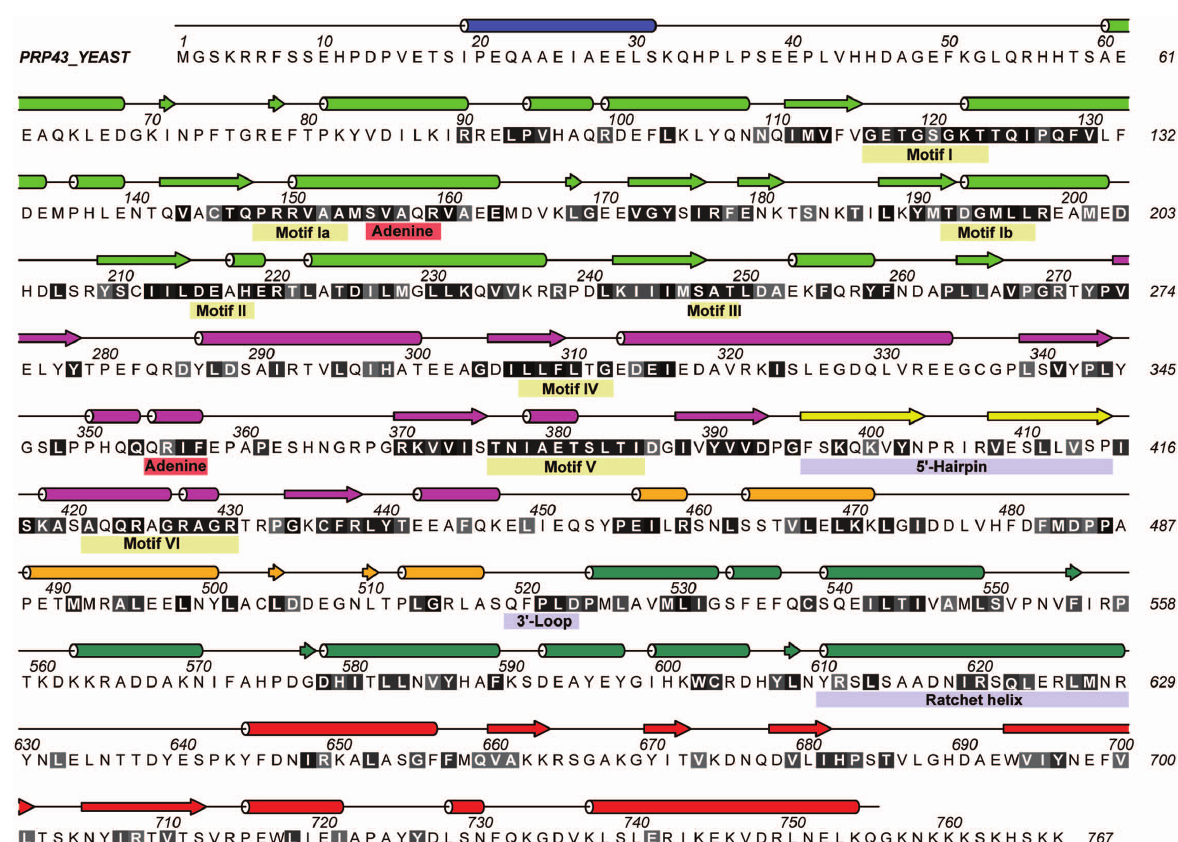
Figure 2 Structural features of DEAH/RHA helicases mapped on yeast Prp43p with the sequence shaded according to conservation (black, most conserved; white, not conserved) after alignment of known human, Drosophila , Arabidopsis and yeast DEAH/RHA sequences (see